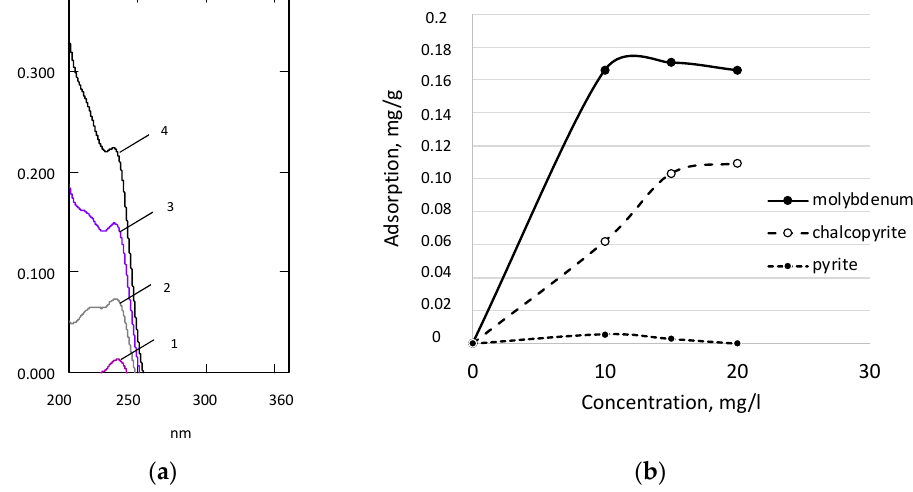
Figure 3. UV Spectra of the composite reagent CR at variable concentrations: 5 (1), 10 (2), 15 (3) and 20 (4) mg/L ( a ); CR adsorption curves via CR concentration ( b ).